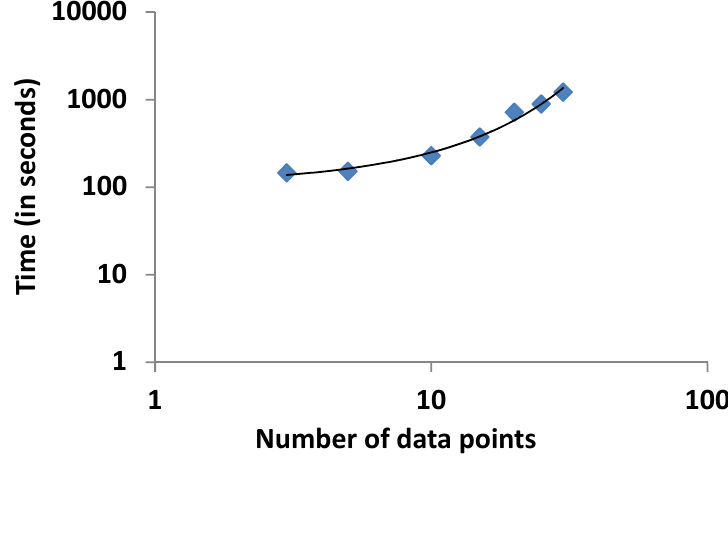
Figure 6. Relationship between number of input data points and computing time. PVA was performed for a single reaction of two substrates, two products, one enzyme and six kinetic parameters. PVA was repeated six times and for each iteration the number of data points in the input dataset for parameter estimation was increased from 3 to 30. The results show a rising curve in a non-linear